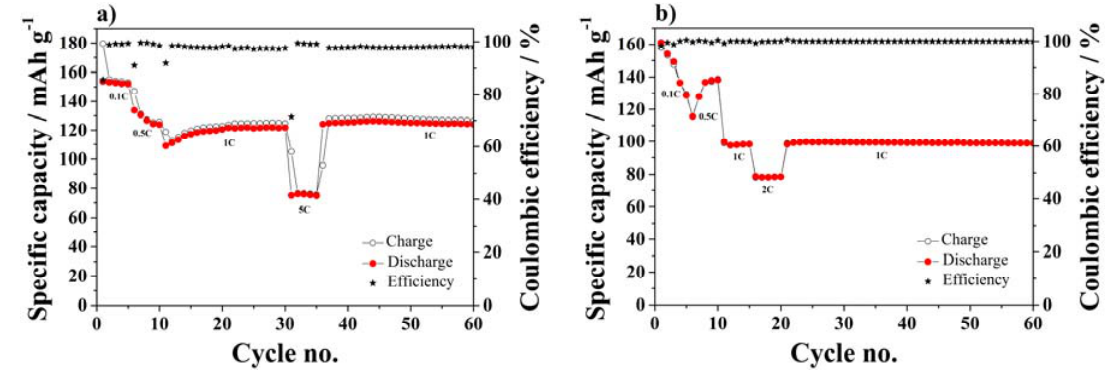
Figure 8. Cycle performance at different C-rates using SiO 2 –HPG membrane as separator in ( a ) NMC; ( b ) and LTO